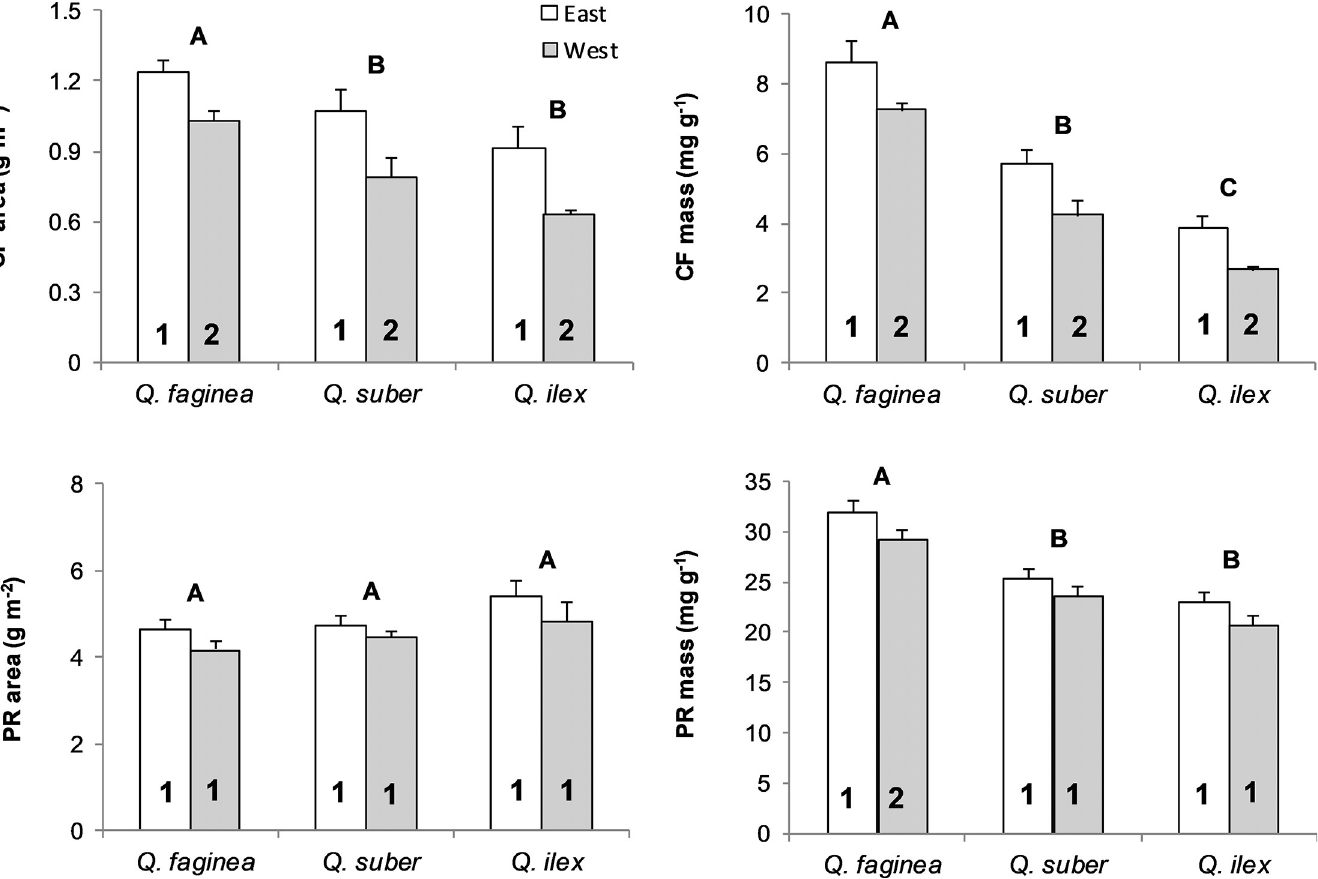
Fig 2. Mean + SE (n = five trees) leaf chlorophyll (CF) and soluble protein (PR) content at two canopy positions. Different numbers within bars indicate significant differences (P < 0.05) between canopy positions. Different letters above bars indicate significant differences (P < 0.05) between species pairs (Posthoc Tukey HSD test).